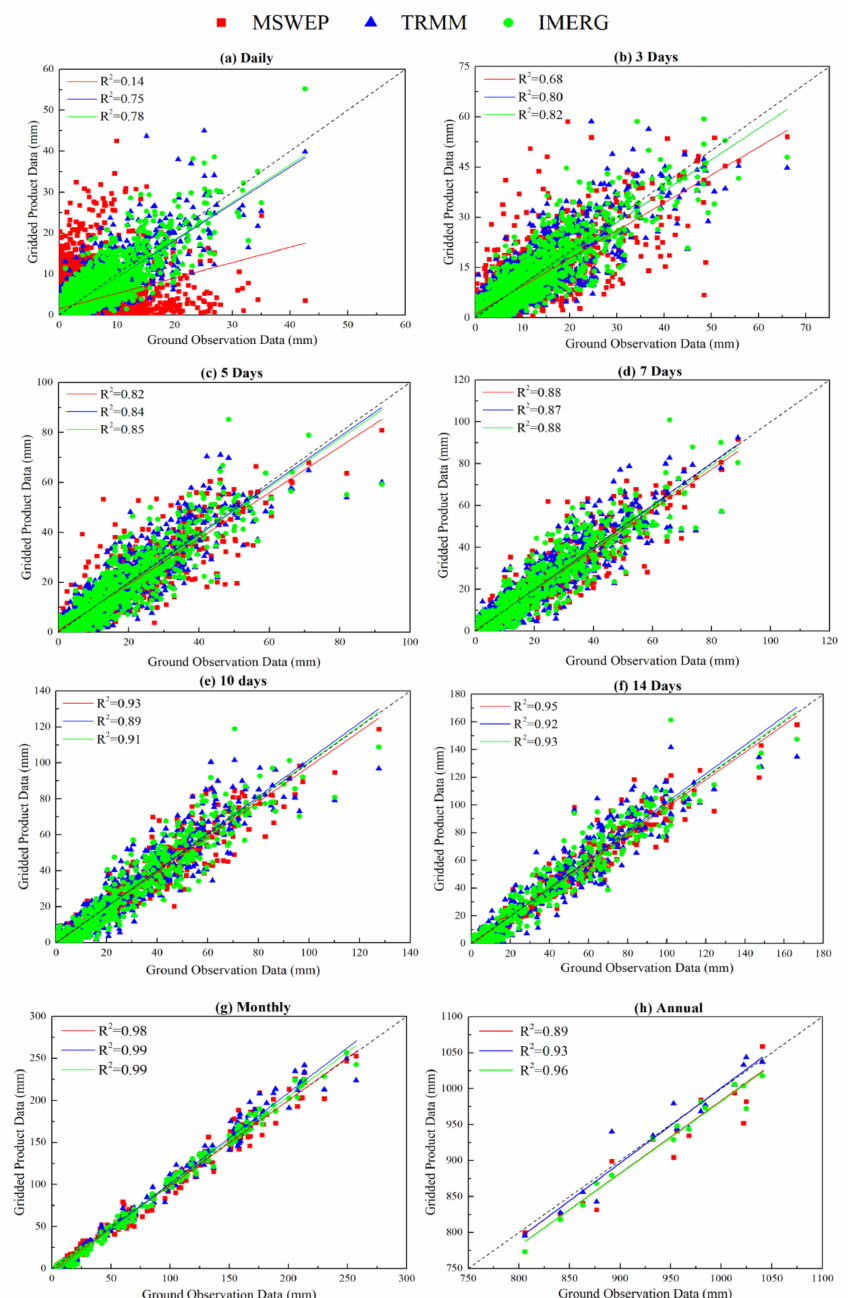
Figure 2. Scatterplots of ground observations versus precipitation derived from MSWEP, TRMM, and IMERG products with different temporal resolutions at the watershed scale. ( a – h ) show the comparison at the daily, 3 days, 5 days, 7 days, 10 days, 14 days, monthly, and annual temporal scales, respectively. The black dashed line indicates the 1:1 correspondence, and the red, blue, and green solid lines represent the best linear regression fits for MSWEP, TRMM, and IMERG, respectively. The continuous statistical metrics ( CC , RRMSE , RMAE , RB , and modified KGE ) of the comparisons between gridded precipitation products and ground observation data for different timescales (daily, 3 days, 5 days, 7 days, 10 days, 14 days, monthly, and annual) are plotted in Figure